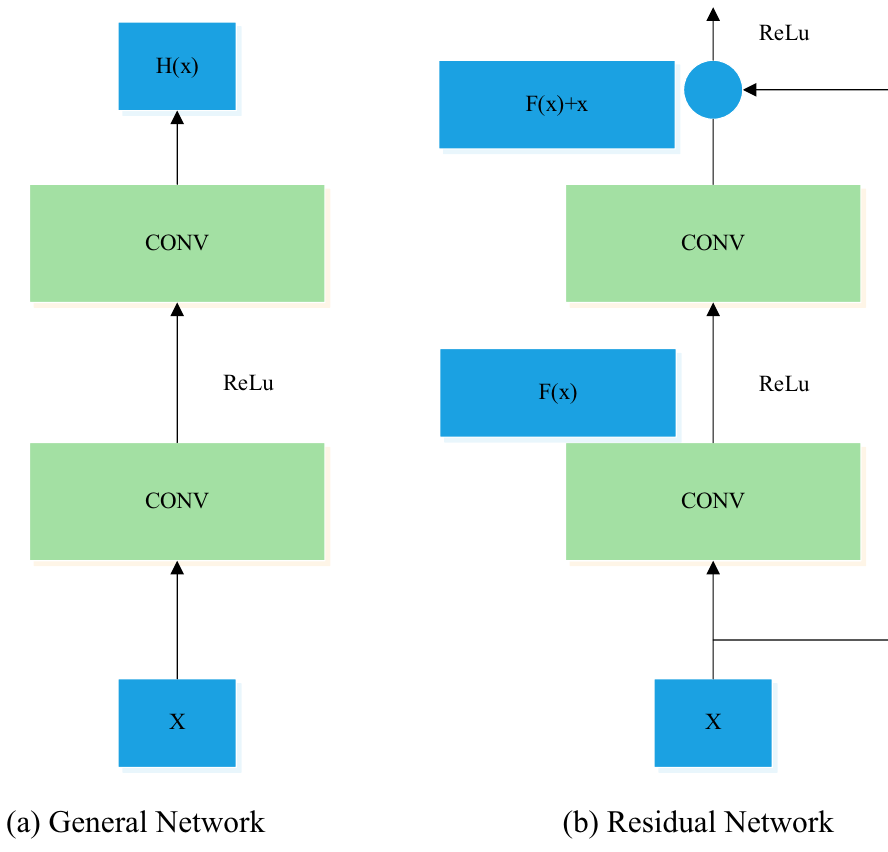
Fig. 2 Comparison of general network and residual network